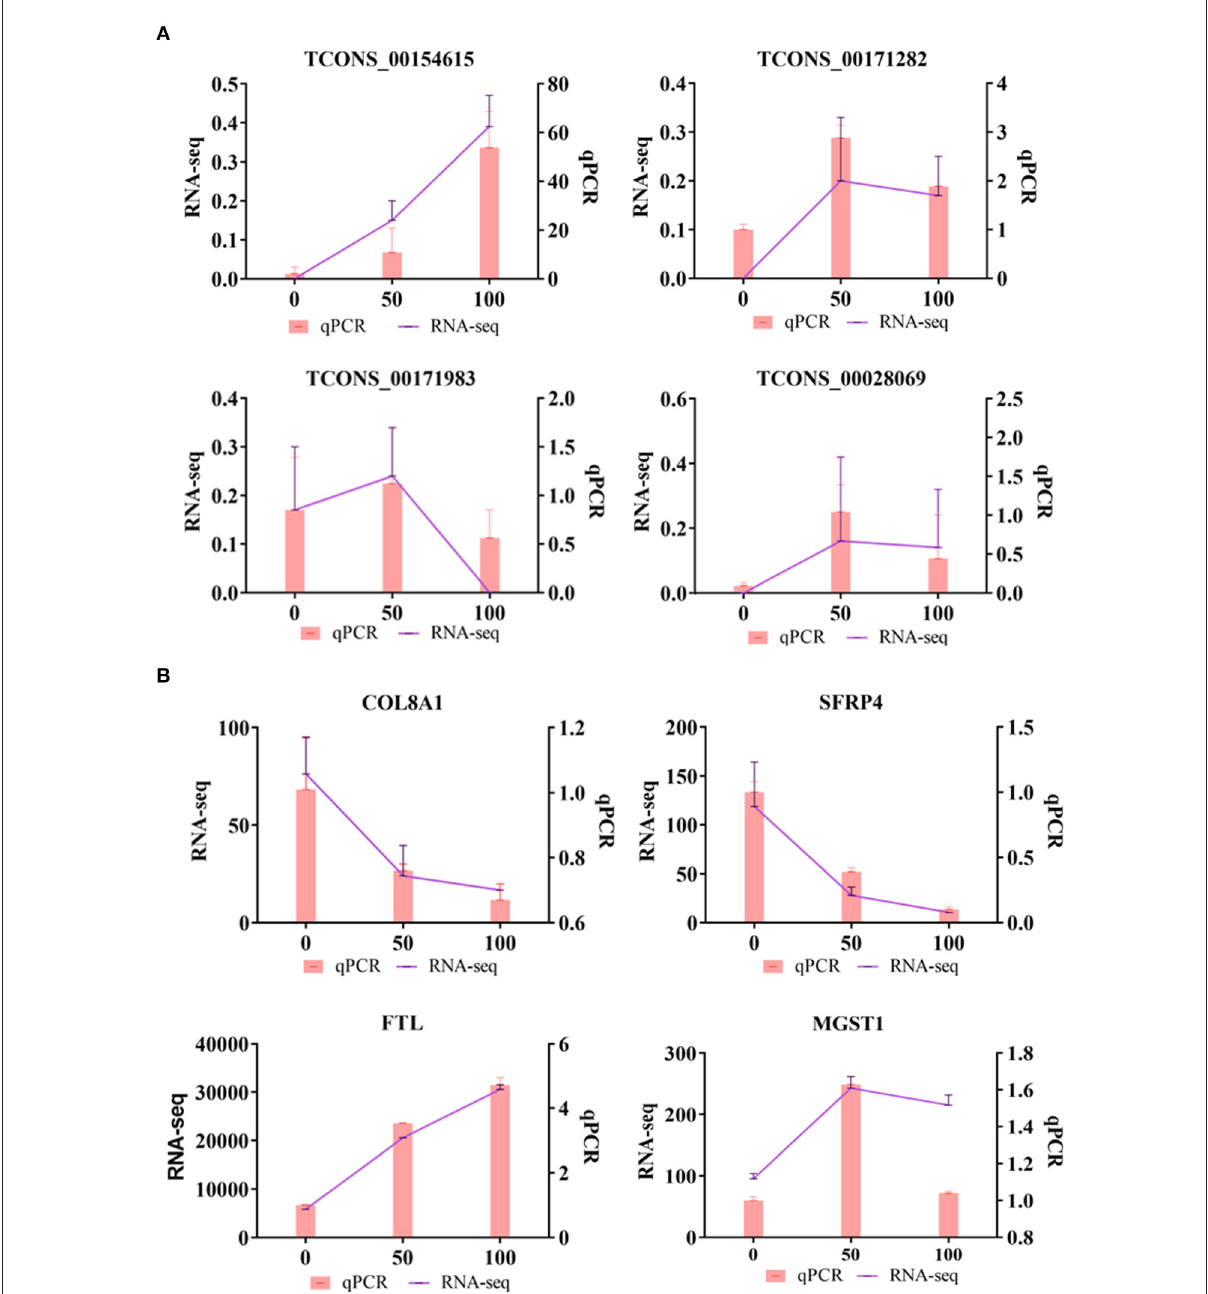
FIGURE5 Quantitative real-time PCR (qRT-PCR) validations. (A) Verification of DELs by qRT-PCR. (B) Verification of differentially DEMs by qRT-PCR.